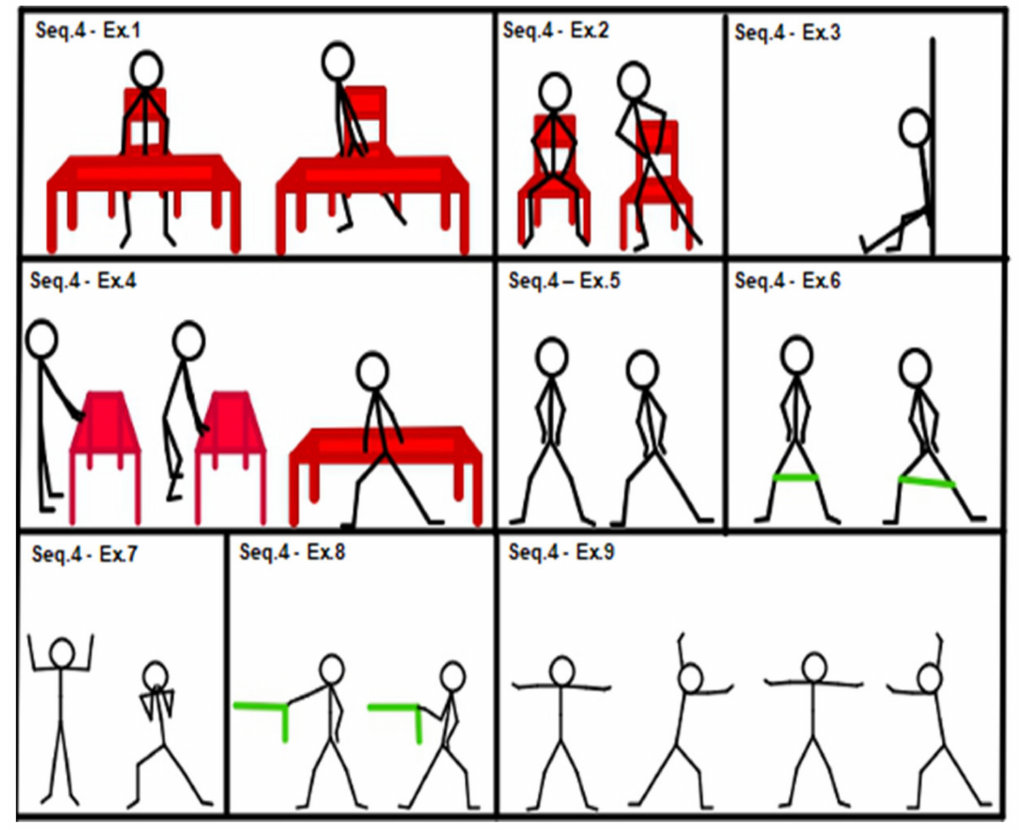
Figure 4. Sequence 4: lower limbs, medium level.